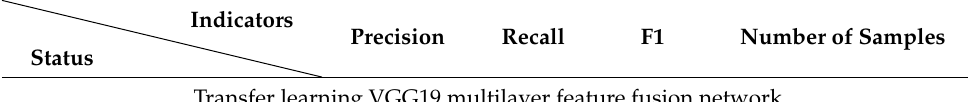
Table 2. Performance comparison of the two network models on the test